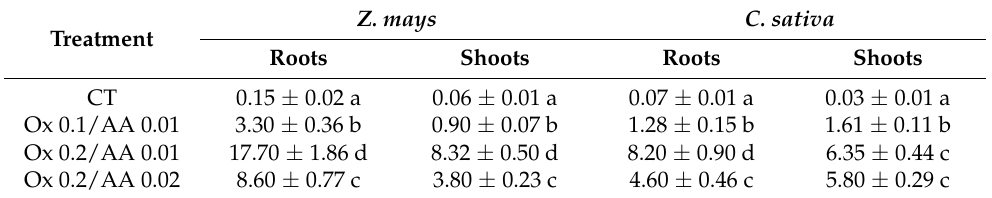
Table 2. As concentrations (mg kg − 1 ) in roots and shoots of Z. mays and C. sativa grown on As- contaminated soils treated with different mixtures of oxalate and ascorbic acid (microcosm tests). The values are the means of three replicates and the error bars show ± standard deviations. The different letters within the same column represent different significance levels at p < 0.05 (Tukey’s test). Z. mays C. sativa Treatment Roots Shoots Roots Shoots